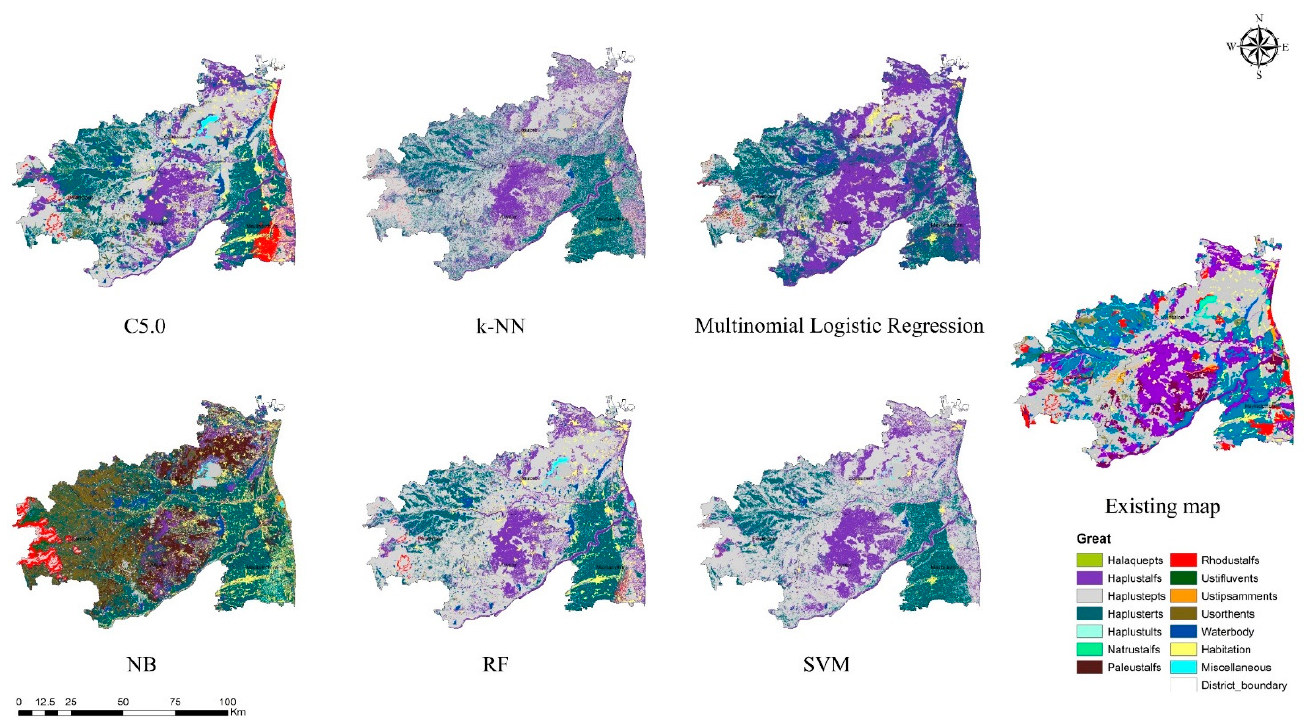
Figure 7. Existing and predicted maps of the great group using different machine learning algo- rithms.